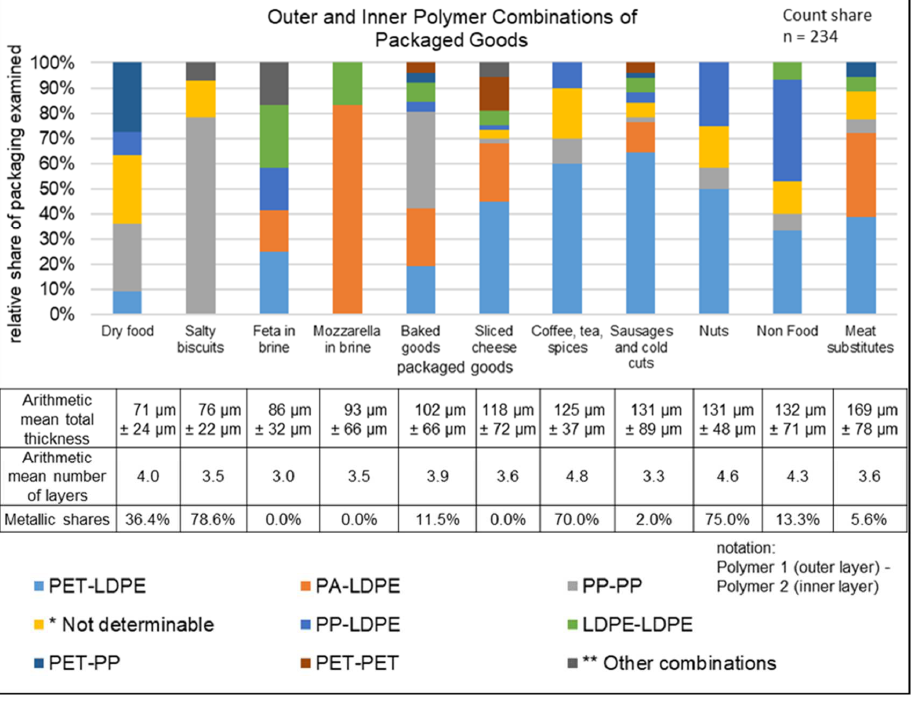
Figure 4. Outer and inner layer polymer combinations for different packaged goods. * PA-n.d.; PET-n.d.; n.d.-n.d.; n.d.-PP; n.d.-LDPE; ** PP-PET; LDPE-PET; PET-HDPE; HDPE-PA; PA-PA 4.3.1. Number of Layers, Total Thickness, and Outer and Inner Layer Polymer Combinations